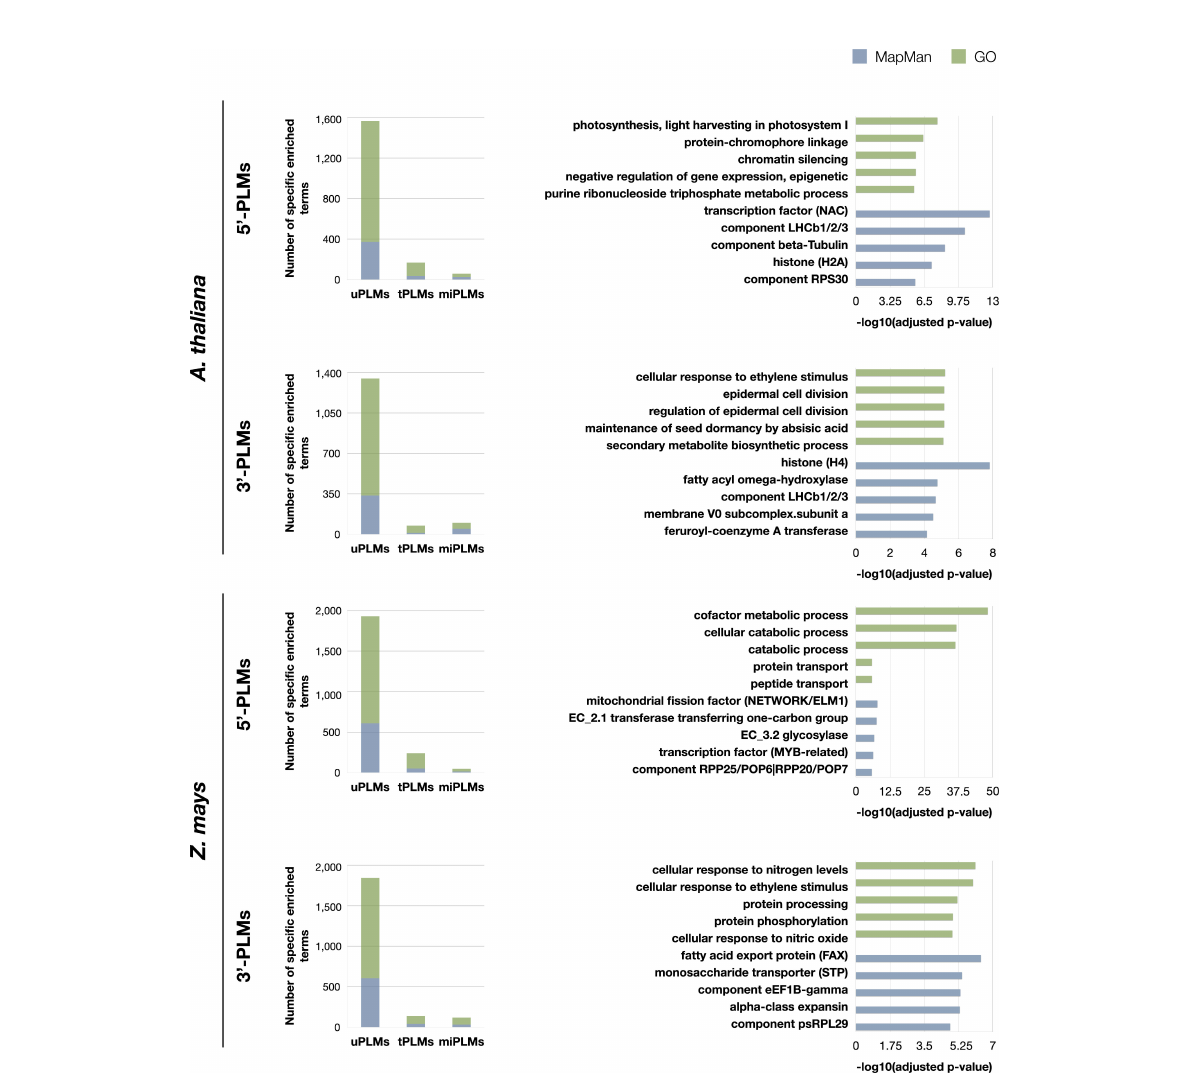
FIGURE 6 GO and MapMan terms enriched speci fi cally for each type of PLMs-containing gene sets. Values for GO and Mapman terms are shown in green and blue, respectively. On the left: histograms of the number of GO and MapMan terms enriched speci fi cally for each type of PLMs-containing gene sets in the two species studied. On the right: the 5 most enriched terms speci fi cally for uPLMs. The bar values of the histograms indicate the -log(adjusted p-values) for each term. Map-Man terms have been truncated at the maximum precision level. The corresponding integer MapMan terms are as follows: transcription factor (NAC): RNA biosynthesis. transcriptional regulation.transcription factor (NAC); component LHCb1/2/3: Photosynthesis.photophosphorylation.photosystem II.LHC-II complex.component LHCb1/2/3; component beta-Tubulin: Cytoskeleton organisation.microtubular network.alpha-beta-Tubulin heterodimer.component beta-Tubulin; histone (H2A): Chromatin organization. histones.histone (H2A); component RPS30: Protein biosynthesis.ribosome biogenesis.small ribosomal subunit (SSU).SSU proteome.component RPS30; histone (H4): Chromatin organisation.histones.histone (H4); fatty acyl omega-hydroxylase: Cell wall organisation.cutin and suberin.cuticular lipid formation.fatty acyl omega-hydroxylase; membrane V0 subcomplex.subunit a: Solute transport.primary active transport.V-type ATPase complex.membrane V0 subcomplex.subunit a; feruroyl-coenzyme A transferase: Cell wall organisation.cutin and suberin.alkyl-hydrocinnamate biosynthesis.feruroyl-coenzyme A transferase; mitochondrial fi ssion factor (NETWORK/ ELM1): Cell cycle organisation.organelle division.mitochondrion and peroxisome division.mitochondrial fi ssion factor (NETWORK/ELM1); EC_2.1 transferase transferring one-carbon group: Enzyme classi fi cation.EC_2 transferases.EC_2.1 transferase transferring one-carbon group; EC_3.2 glycosylase: Enzyme classi fi cation.EC_3 hydrolases.EC_3.2 glycosylase; transcription factor (MYB-related): RNA biosynthesis.transcriptional regulation.MYB transcription factor superfamily.transcription factor (MYB-related); component RPP25/POP6|RPP20/POP7: RNA processing.ribonuclease activities.RNA-dependent RNase P complex.component RPP25/POP6|RPP20/POP7; fatty acid export protein (FAX): Lipid metabolism.lipid traf fi cking.fatty acid export protein (FAX); monosaccharide transporter (STP): Solute transport.carrier-mediated transport.MFS superfamily. SP family.monosaccharide transporter (STP); component eEF1B-gamma: Protein biosynthesis.translation elongation.eEF1 aminoacyl-tRNA binding factor activity.eEF1B eEF1A-GDP-recycling complex.component eEF1B-gamma; alpha-class expansin: Cell wall organisation.cell wall proteins.expansin activities.alpha-class expansin; component psRPL29 Protein biosynthesis.organelle machinery.plastidial ribosome.large ribosomal subunit proteome.component